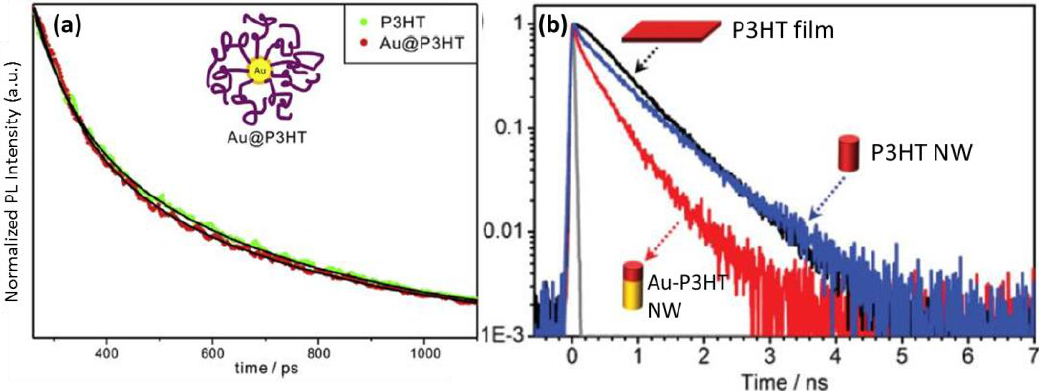
Figure 21. ( a ) Picosecond time-resolved fluorescence kinetic profiles of P3HT and Au@P3HT in chloroform. Samples were excited at 355 nm and monitored at 580 nm, and solid lines are the best-fitted curves to extract kinetic constants. The inset is the schematic structure of Au@P3HT nanocomposite [103]. ( b ) PL lifetime decays of a P3HT thin film (black), a single P3HT nanowire (blue), and a gold-P3HT nanowire (red) along with the instrument response function (IRF) of the PL lifetime system (grey) [95]. Reprinted with permission from ref [97]. Reprinted with permission from Refs. [95,103].